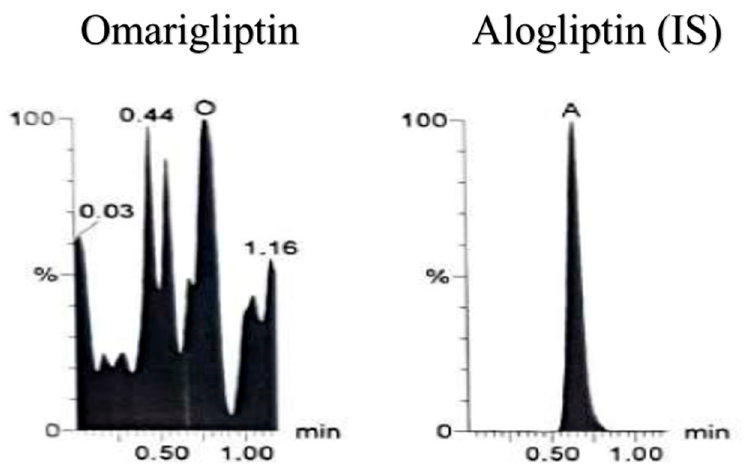
Figure 5. Blank plasma sample using liquid chromatography tandem mass spectrometry (LC- MS/MS).